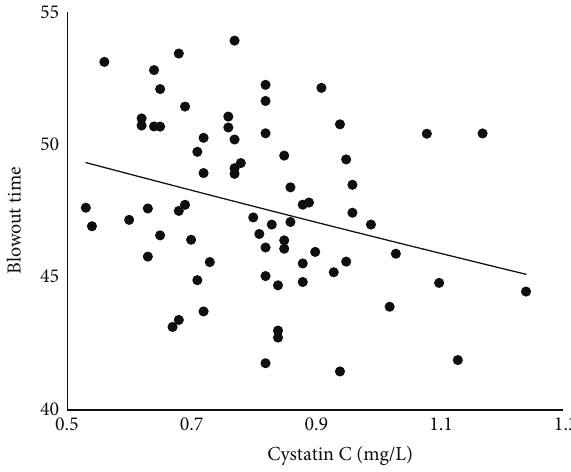
Figure 4: Correlation between blowout time and serum cystatin C in all